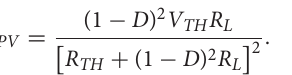
FIGURE 5 | The relationship between PV power and the duty cycle of the MPPT boost